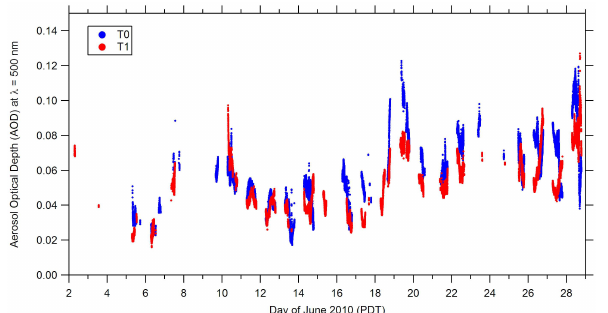
Fig. 20. Comparison of aerosol optical depth derived from MFRSR observations at T0 and T1 sites.